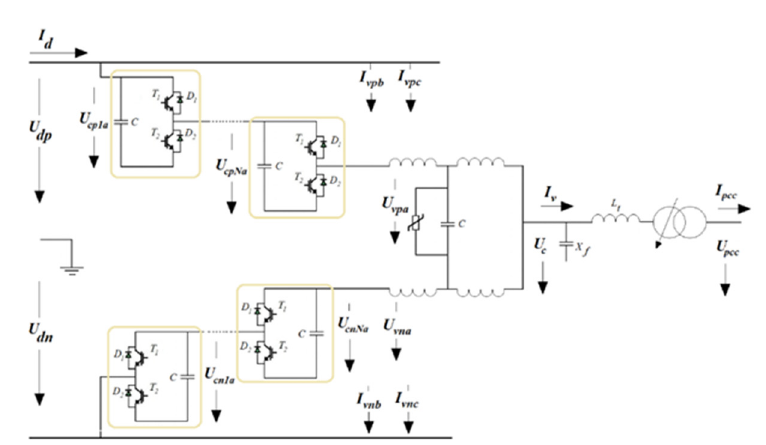
Figure 24. CTL-HVDC Topology (ABB).